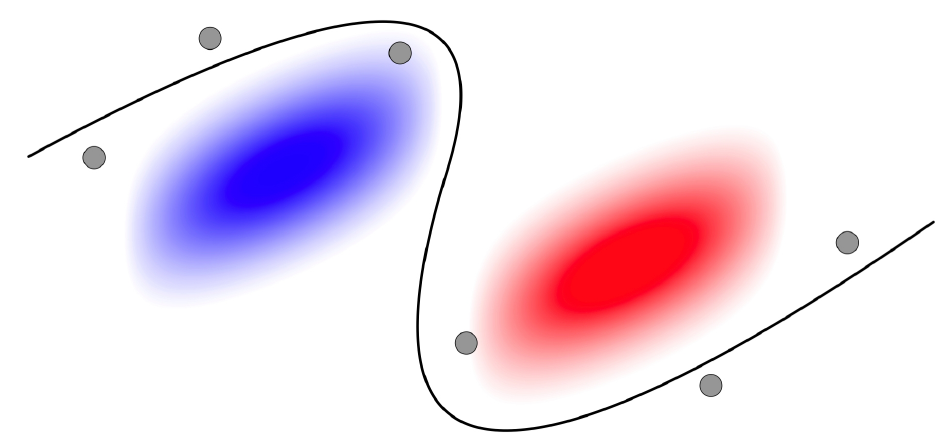
Figure 8. A schematic showing the preferential arrangement of coherent vortices along large-scale velocity isocontours and their relationship to large scale structures. The red and blue ellipse here denote high and low-speed large-scale structures respectively while the black solid line denotes a velocity iso-contour. The smaller grey circles indicate the position of coherent vortices in the